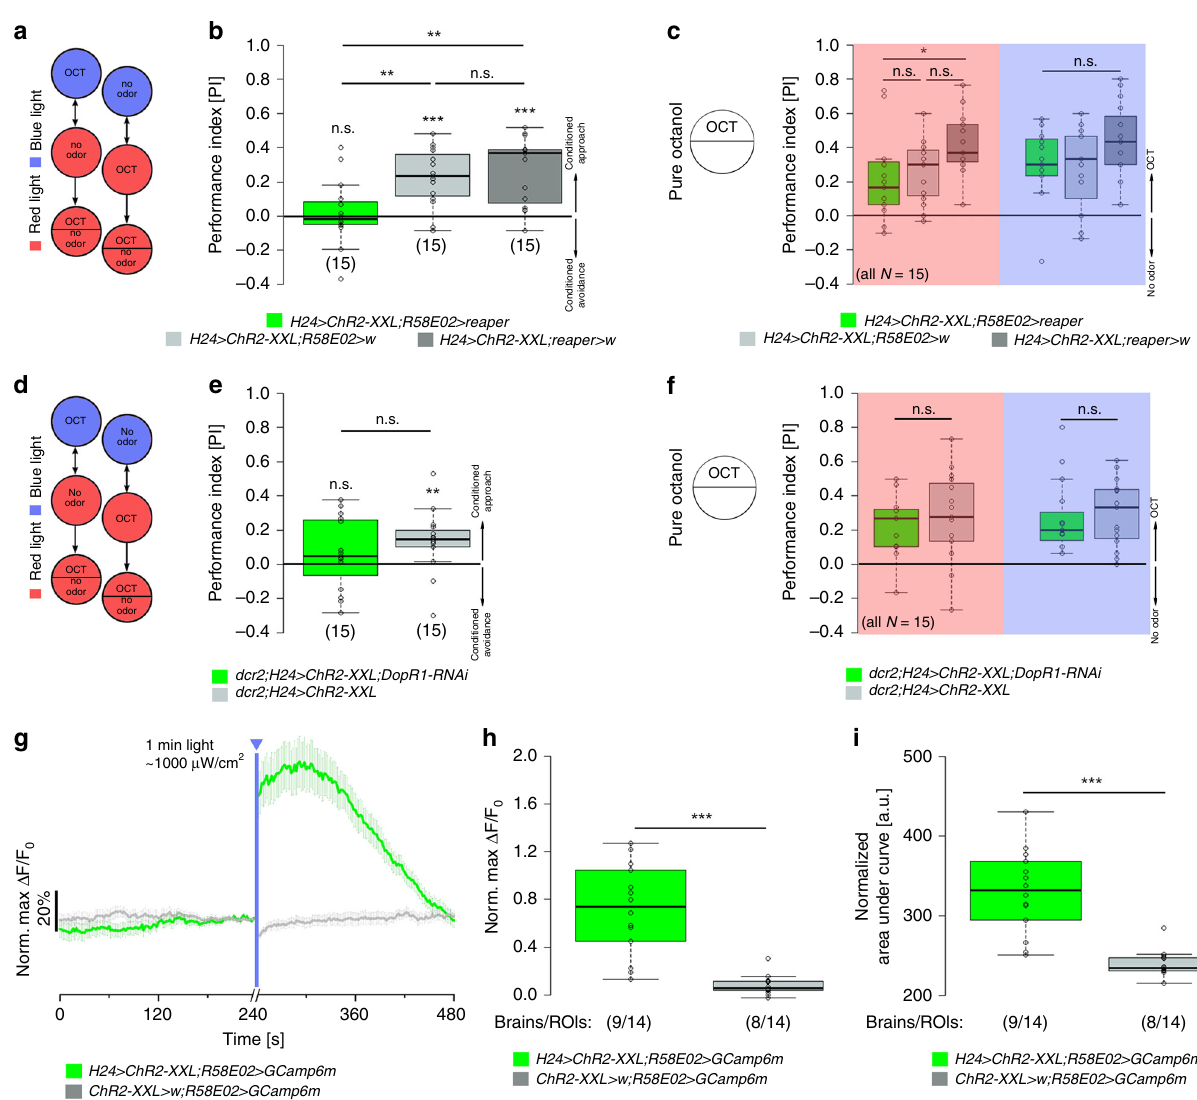
Fig. 4 Arti fi cially induced memory expression depends on KC-to-pPAM signaling. a , b Optogenetic activation of KCs and simultaneous ablation of pPAM neurons via the expression of the apoptotic gene reaper impairs optogenetically induced appetitive memory. c Innate odor preference is unchanged in experimental larvae under red and blue light. d , e Similarly, optogenetic activation of KCs and simultaneous knockdown of the dopamine receptor DopR1 impairs appetitive memory formation. f Innate odor preference is unchanged in experimental larvae under red light (red rectangle) and blue light (blue rectangle). g – i pPAM neurons respond with a signi fi cant increase in fl uorescence intensity to optogenetic activation of MB KCs (green) both in the maximum values ( h ) and area under the curve ( i ) verifying a functional KC-to-pPAM feedback connection ( N = 14 ROIs from 9 brains). An increase in fl uorescence intensity was absent in genetic controls (gray; N = 14 ROIs from 8 brains). ChR2-XXL: channelrhodopsin2-XXL; KCs: Kenyon cells; MB: mushroom body; OCT: octanol; ROI: Region of interest; w: w 1118 . The number below the box plots refers to the N number. A pairwise Student ’ s t test or pairwise Wilcoxon test (both including Bonferroni-Holm correction) was used. Signi fi cance levels: n.s. p > 0.05, * p < 0.05, ** p < 0.01, *** p < 0.001. Error bars ( g ) represent the standard error of the mean. Data are mainly presented as box plots, with 50% of the values of a given genotype being located within the box, and whiskers represent the entire set of data. No data were excluded. Outliers are indicated as open circles. The median performance index is indicated as a thick line within the box